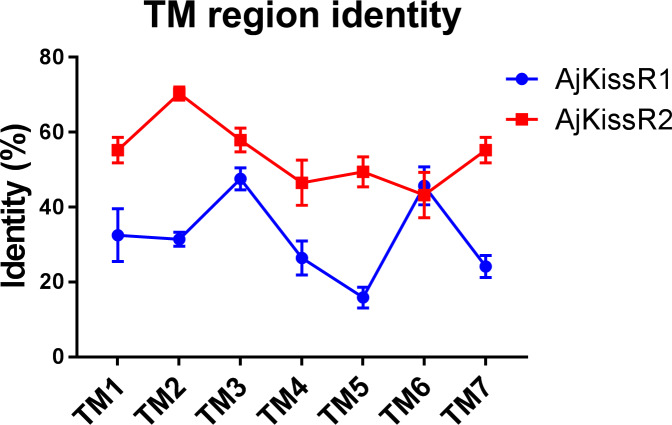
Transmembrane region sequence similarity of Apostichopus japonicus kisspeptin receptors to vertebrate kisspeptin receptors.Figure 2—figure supplement 3—source data 1 lists the detailed identities.Figure 2—figure supplement 3—source data 1.Primary metadata of detailed identities for Figure 2—figure supplement 3.